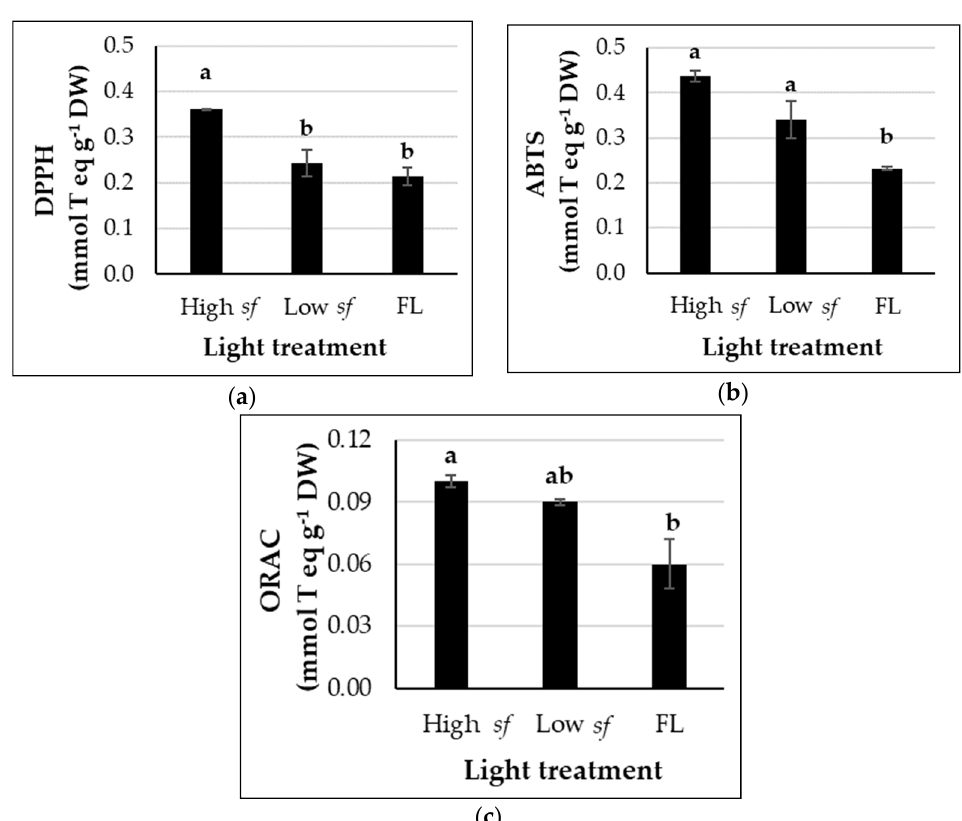
Figure 4. Effect of different lighting treatments on the Total Antioxidant Capacity of leaf extracts ( n = 3) measured using three different assays, namely DPPH ( a ), ABTS ( b ), and ORAC ( c ). All of the values are expressed as mmol Trolox equivalents (T eq) g − 1 DW. Vertical bars represent standard deviations. Different letters indicate significant differences at p ≤ 0.05.